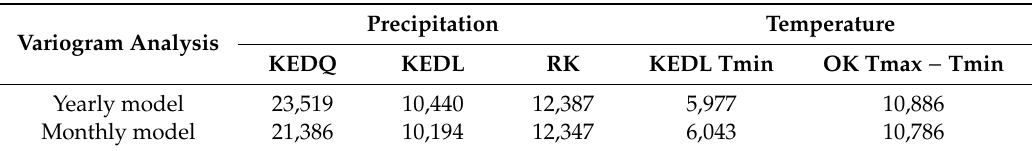
Table 3. Mean squared error (MSE) of precipitation (mm 2 ) and temperature ( ◦ C 2 ) estimates obtained for the cross-validation